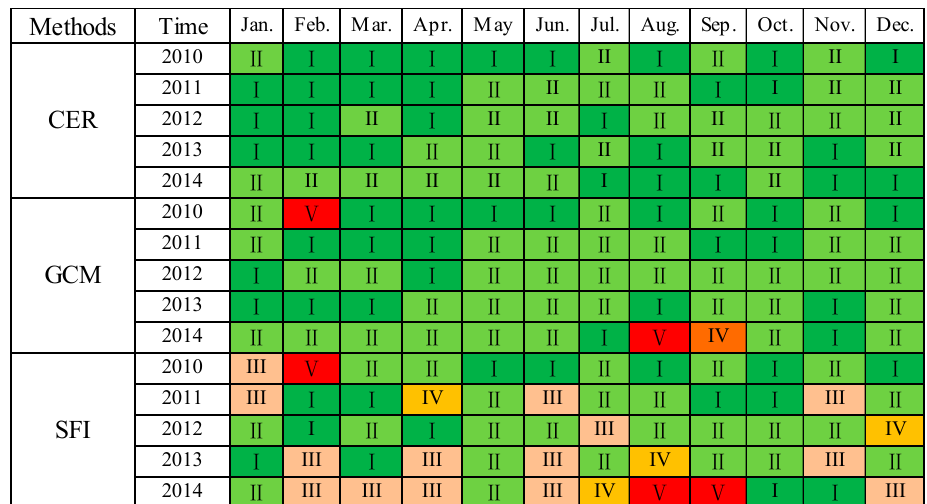
Table 3. Index weights obtained by the three methods.